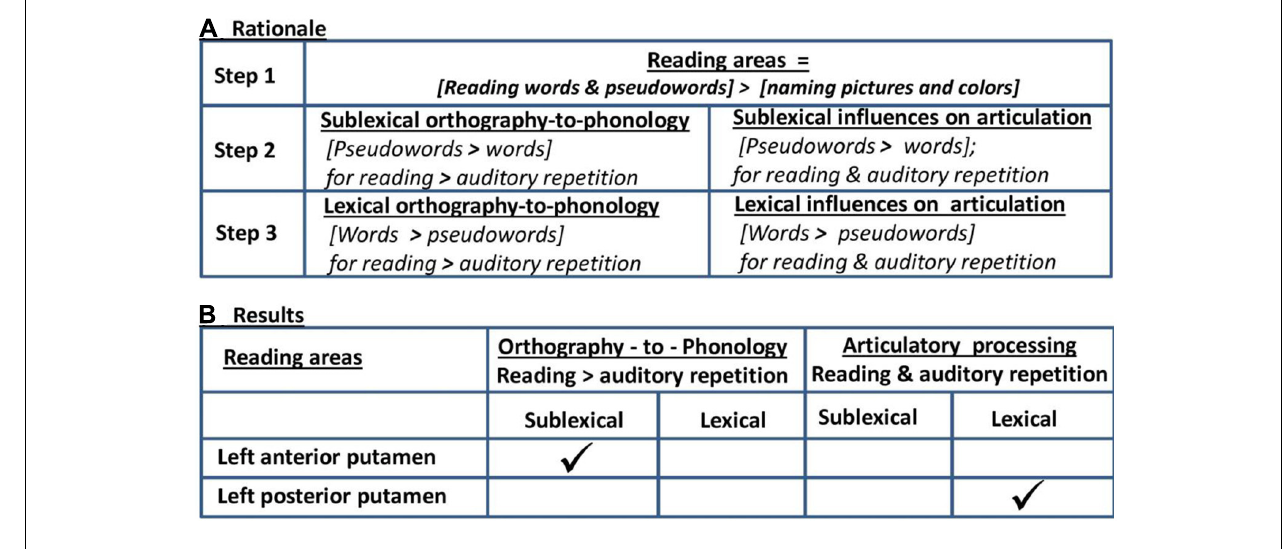
specific to orthographic processing and activation arising at the level of articulation by testing whether the differences between pseudoword and word production was also observed during auditory repetition or not. (B) Results: the only area significant in Step 1 was the left putamen.The anterior putamen was more activated by reading pseudowords than any other condition, consistent with the influence of sublexical orthographic processing.The posterior putamen was more activated by words than pseudowords during reading and repetition, consistent with lexical influences at the level of articulation rather than